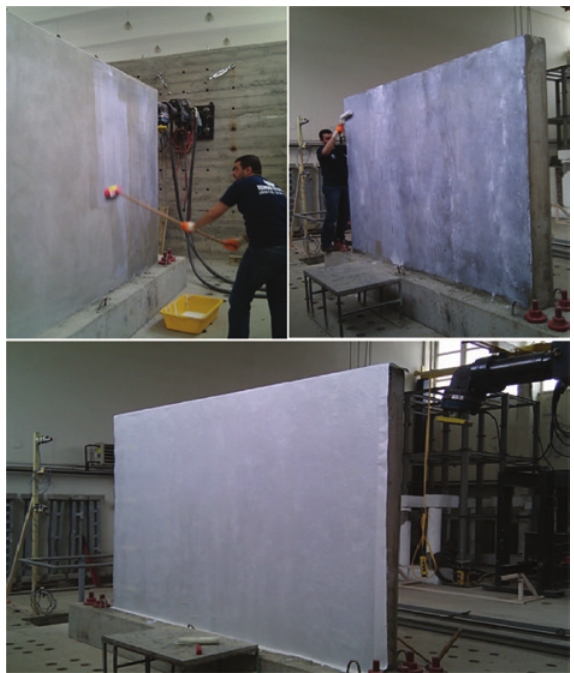
Figure 5: Loading protocol used in the